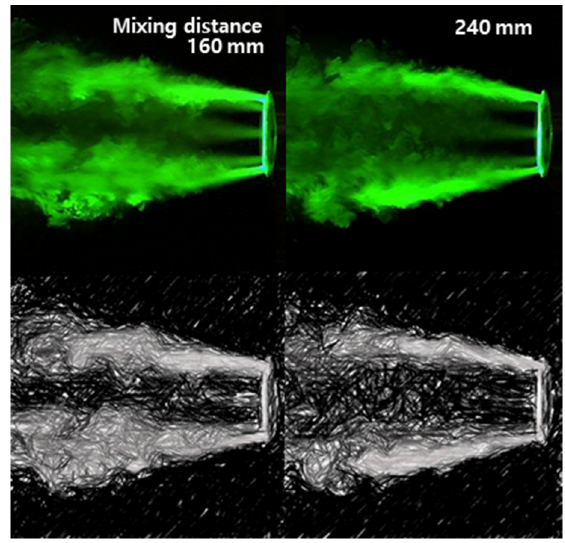
Figure 4. Comparison of the visualized images for the various mixing distances. (“b” nozzle).